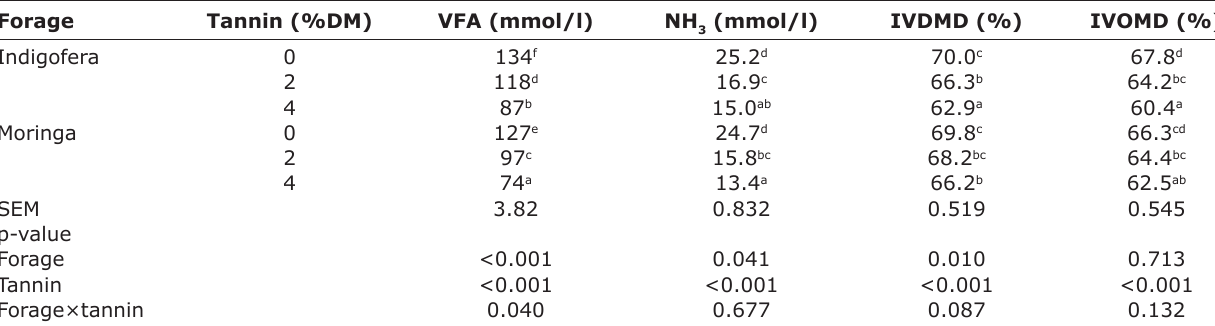
Table-4: In vitro rumen fermentation and digestibility of Indigofera and Moringa leaf silage with different level of chestnut tannin addition. Forage